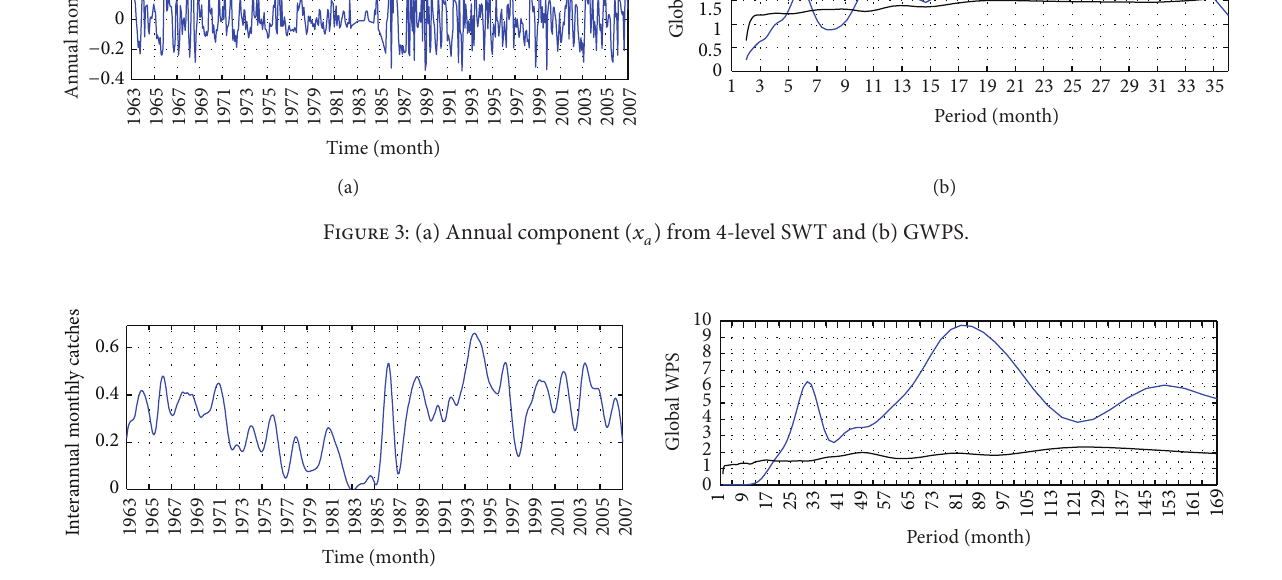
) component from 3 -level SWT and (b) GWPS. ia